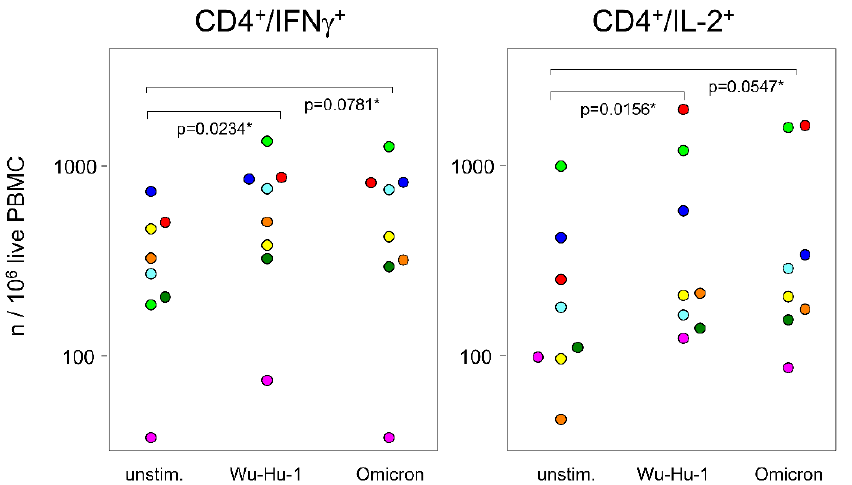
Figure 5. The significant drop in Omicron recognition observed for antibodies does not hold true for T cell memory. Dot plots show absolute numbers of cytokine positive T helper cells. 8 × 10^5 PBMCs were re-stimulated with peptide pools representing either the wild-type spike protein (Wu-Hu-1) or its Omicron variant. Identical colors indicate identical vaccinees, * p values resulted from Wilcoxon matched-pairs signed-ranks tests.